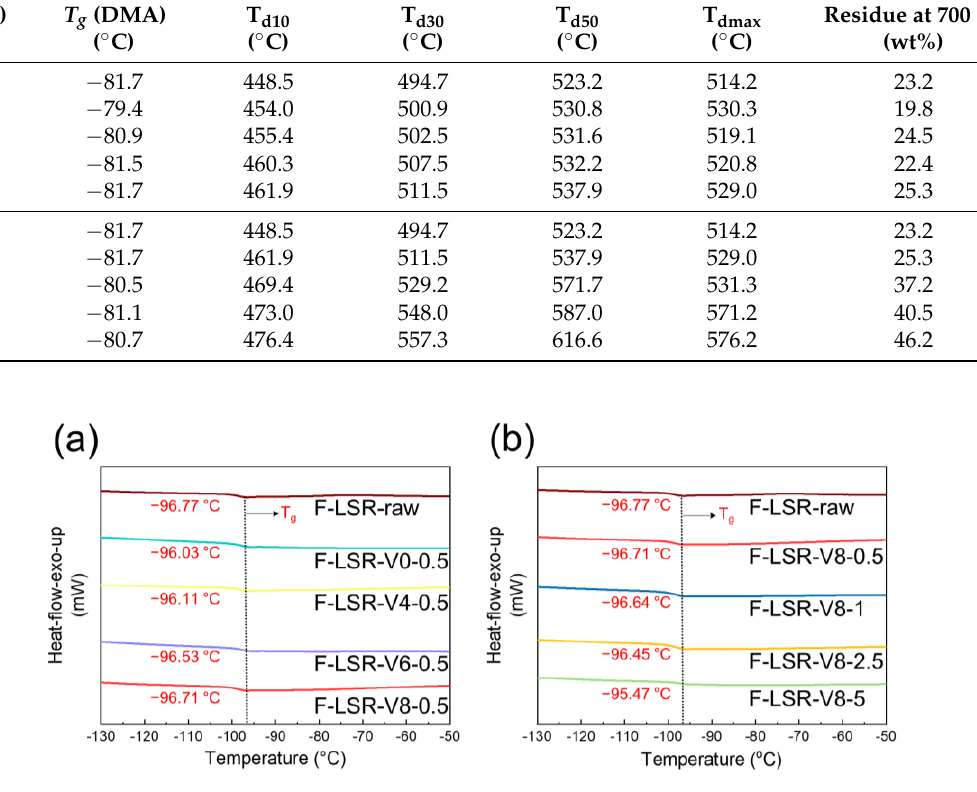
Figure 7. DSC curves of the F-LSR-POSSs with ( a ) various types of POSSs and ( b ) different POSS- V8 loadings.